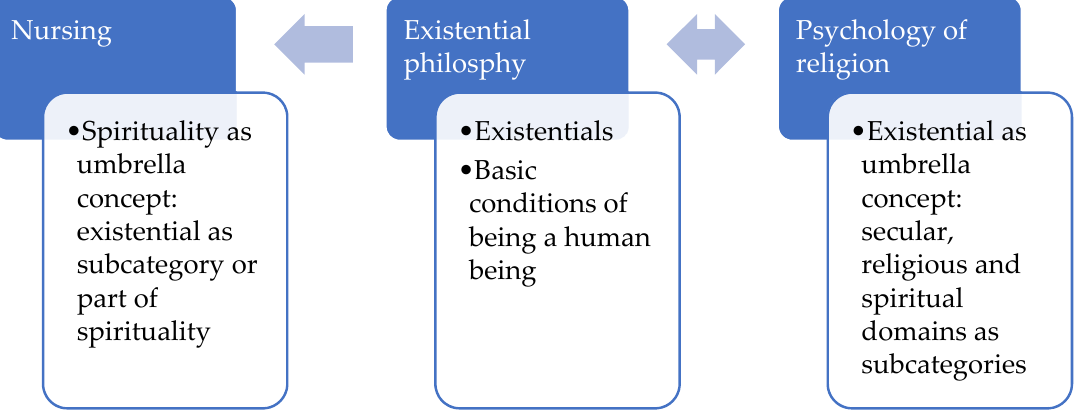
Figure 4. Discourses of ‘existential’ in three research traditions relevant to health research.